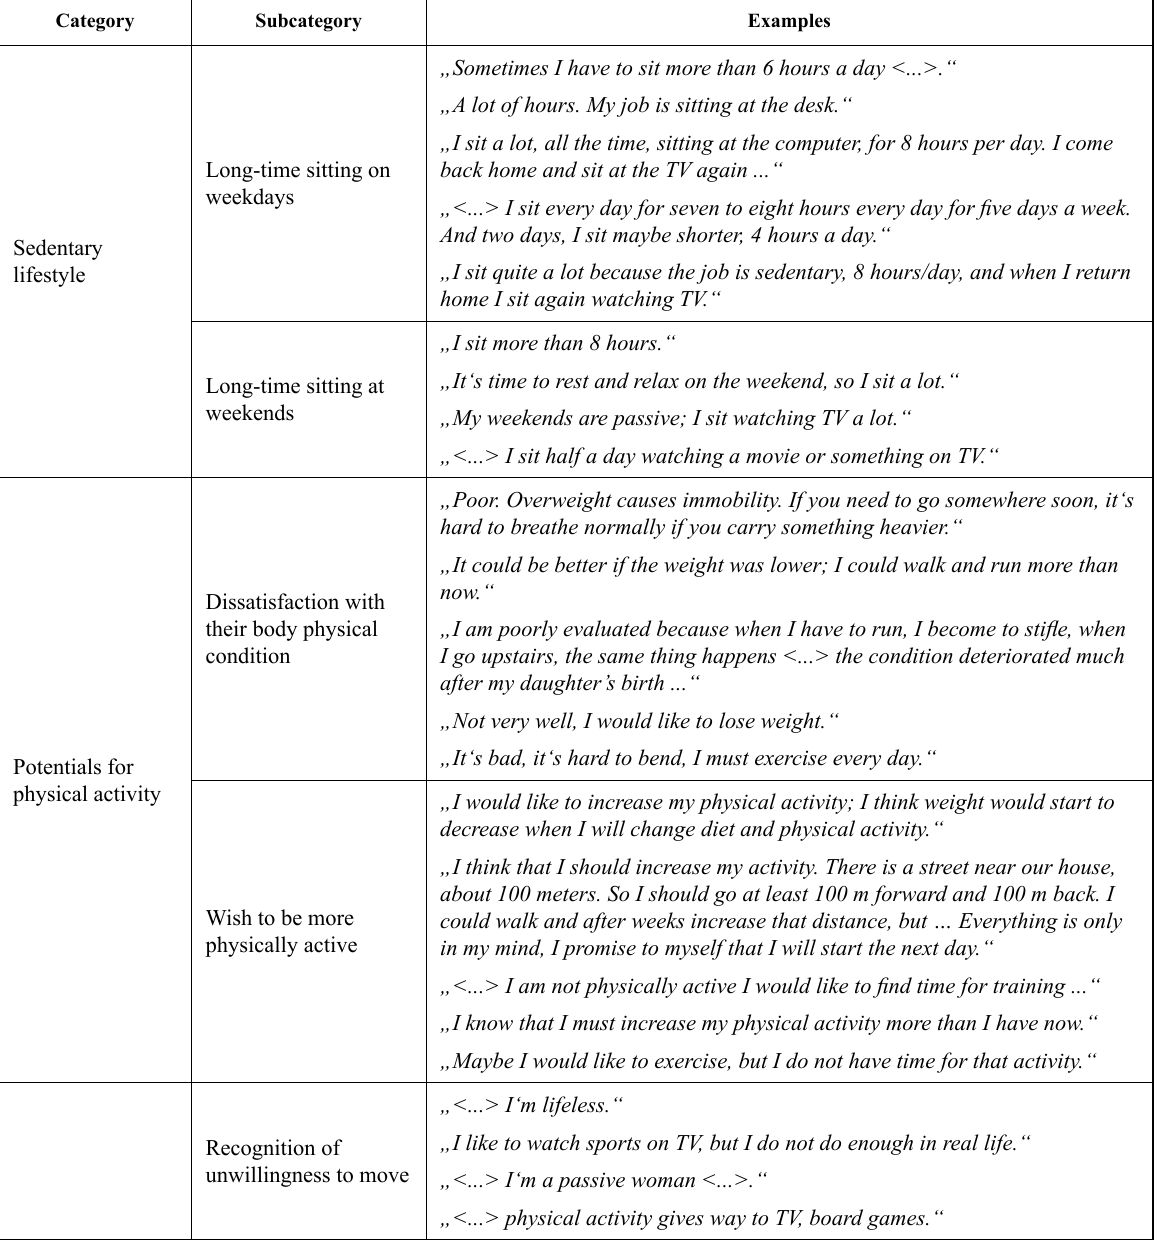
Table 4. Perceptions of lifestyle and physical activity in relationship with